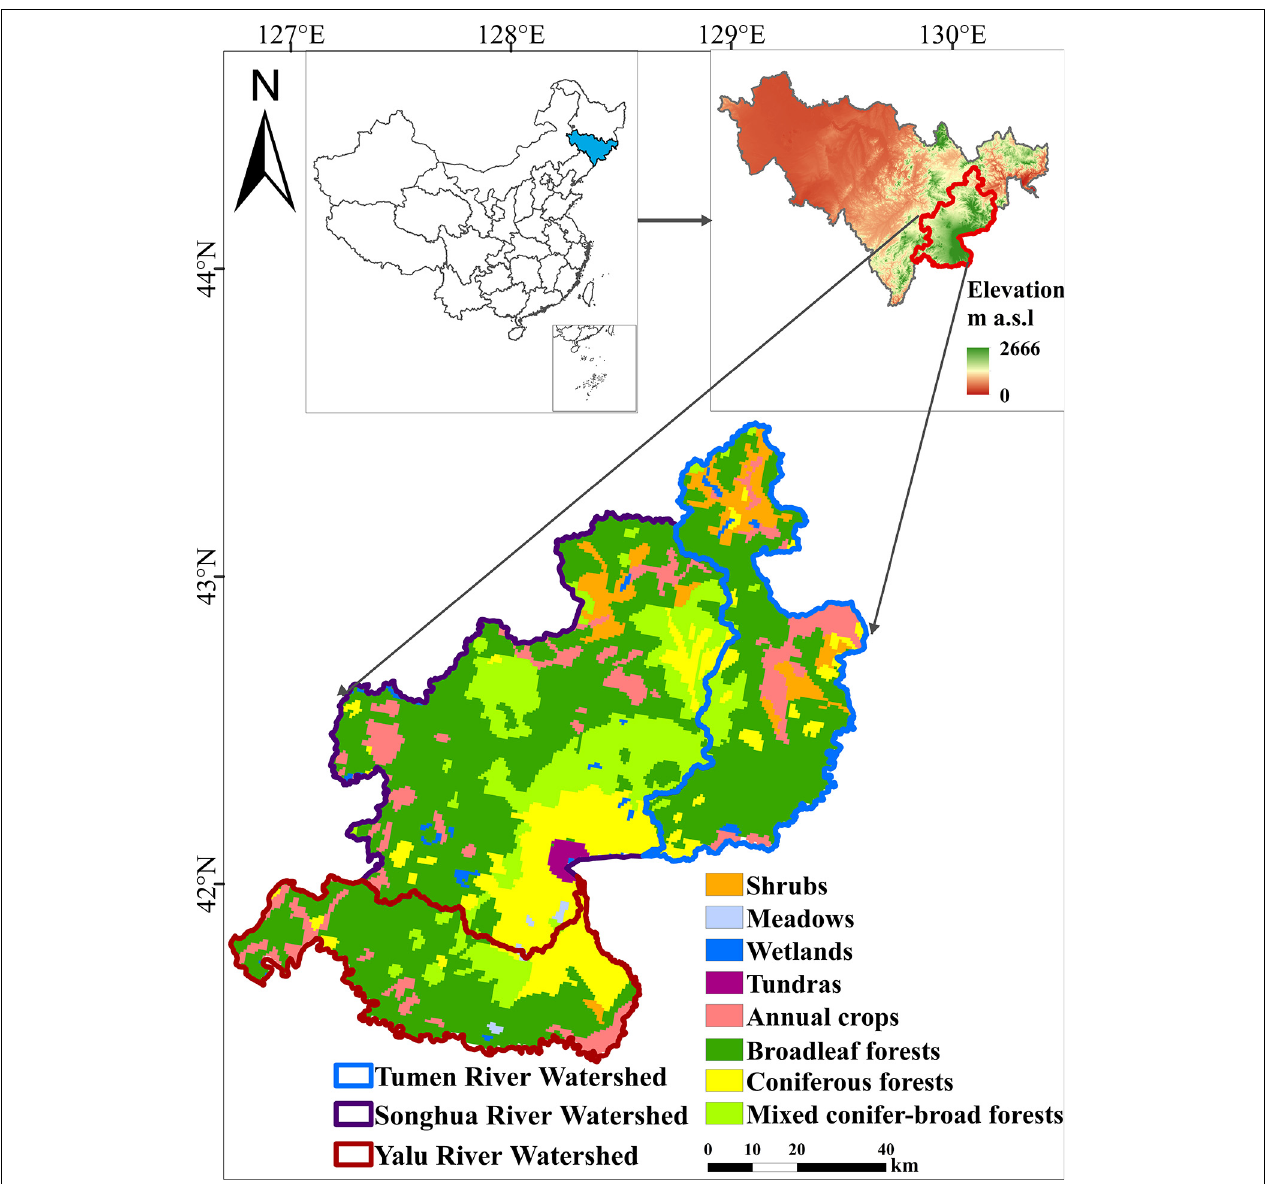
FIGURE 1 | Location, digital elevation model (DEM) and vegetation types (2010) of the Changbai mountains region (CBMR).